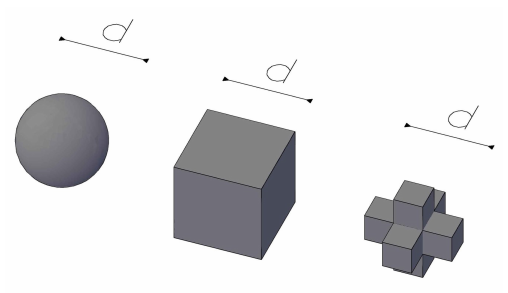
Figure 4. A 3D models of MP particles (left to right): particle groups A, B, and C.